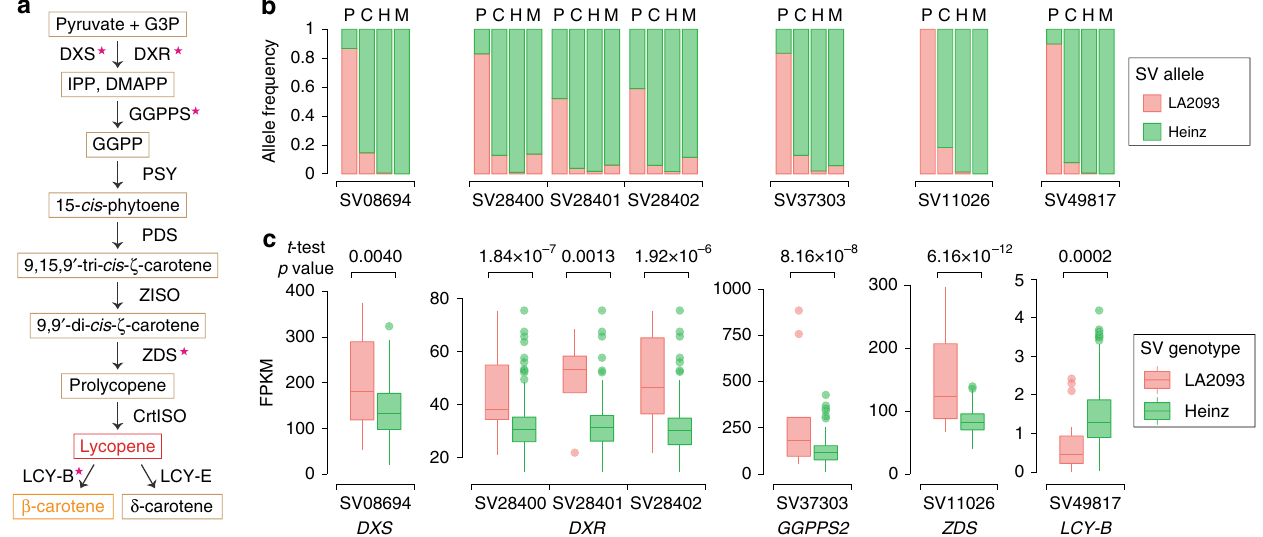
Fig. 3 Selected SVs affecting the expression of lycopene metabolism genes. a Lycopene biosynthesis and degradation pathway in tomato. Stars indicate enzyme-coding genes having selected SVs associated with signi fi cantly different gene expression levels between the two alleles (two-tailed Student ’ s t -test p value <0.01). b Allele frequencies of selected SVs in SP (P), SLC (C), heirloom (H) and modern (M) populations. c Gene expression levels in tomato accessions carrying the homozygous LA2093 and Heinz 1706 alleles, respectively, of the selected SVs. For each SV from left to right, the numbers of accessions with homozygous LA2093 alleles are 11, 20, 4, 10, 9, 9, and 18, and those with homozygous Heinz alleles 162, 210, 131, 129, 164, 155, and 244, respectively. Two-tailed Student ’ s t -test was performed to compare expression levels of each gene between the accessions with homozygous LA2093 and with Heinz alleles for each SV. For each box plot, the lower and upper bounds of the box indicate the fi rst and third quartiles, respectively, and the center line indicates the median. The whisker represents 1.5× interquartile range of the lower or upper quartile. G3P, glyceraldehyde 3-phosphate; IPP, isopentenyl diphosphate; DMAPP, dimethylallyl diphosphate; GGPP, geranylgeranyl diphosphate; DXS, 1-deoxy-d-xylulose 5-phosphate synthase; DXR, 1-deoxy-D- xylulose-5-phosphate reductoisomerase; GGPPS, geranylgeranyl pyrophosphate synthase; PSY, phytoene synthase; ZISO, ζ -carotene isomerase; ZDS, ζ - carotene desaturase; CrtISO, carotene isomerase; LCY-B, lycopene β -cyclase; LCY-E, lycopene ε -cyclase. Source data underlying Fig. 3c are provided as a Source data fi